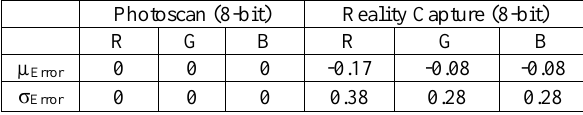
Table 4. 8-bit colour errors (measured in tones) of a colour chart measured before and after processing the images in Agisoft Photoscan (2018) and Capturing Reality Capture (2018)